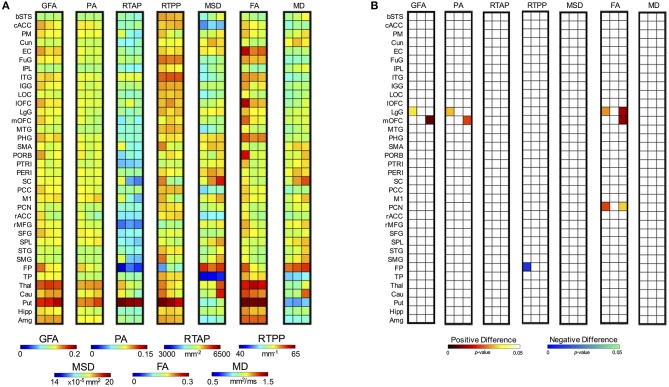
Post-hoc test results for the two-way ANOVA for repeated measures on patients. (A) For each index, the first column represents the mean values at tp1, the second column at tp2 and the third at tp3. (B)
Post-hoc results expressed in terms of p-values for the significant interactions between Time Point (TP) and Region (ROI). Each column in the matrix refers to a specific statistical comparison between time scales, i.e. tpi vs. tpj with i = 1, 2 and j = 2, 3 (first: tp1 vs. tp2; second: tp2 vs. tp3; third: tp1 vs. tp3). Two different colormaps are used to display the p-values for the ROIs with significantly different values between the considered time scales (hot: positive difference, tpi > tpj; cold: negative difference, tpi < tpj). These values (p < 0.05) are Bonferroni corrected for multiple comparisons.